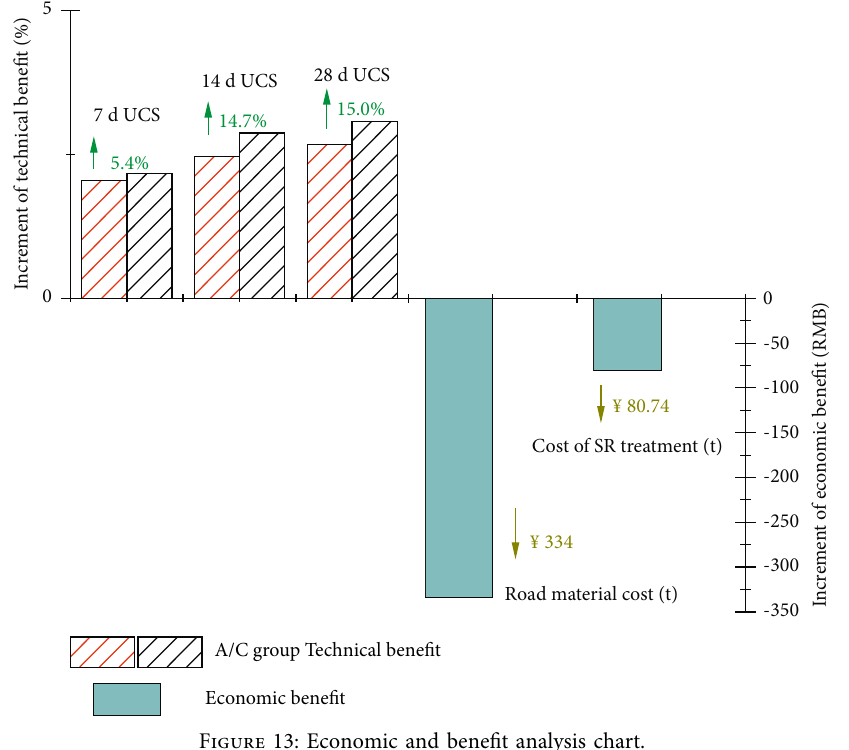
Figure 13: Economic and benefit analysis